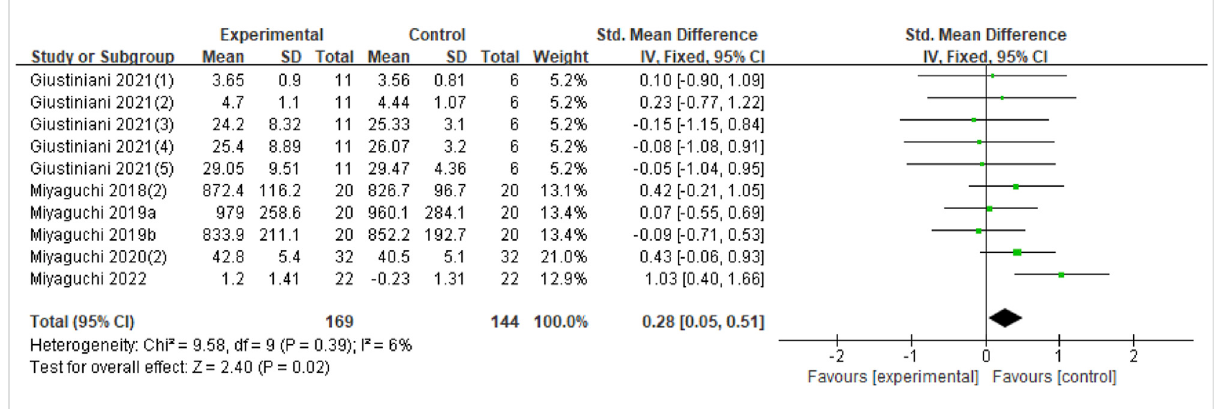
FIGURE 4 Forest plot for the effect of γ -tACS on improving motor performance.